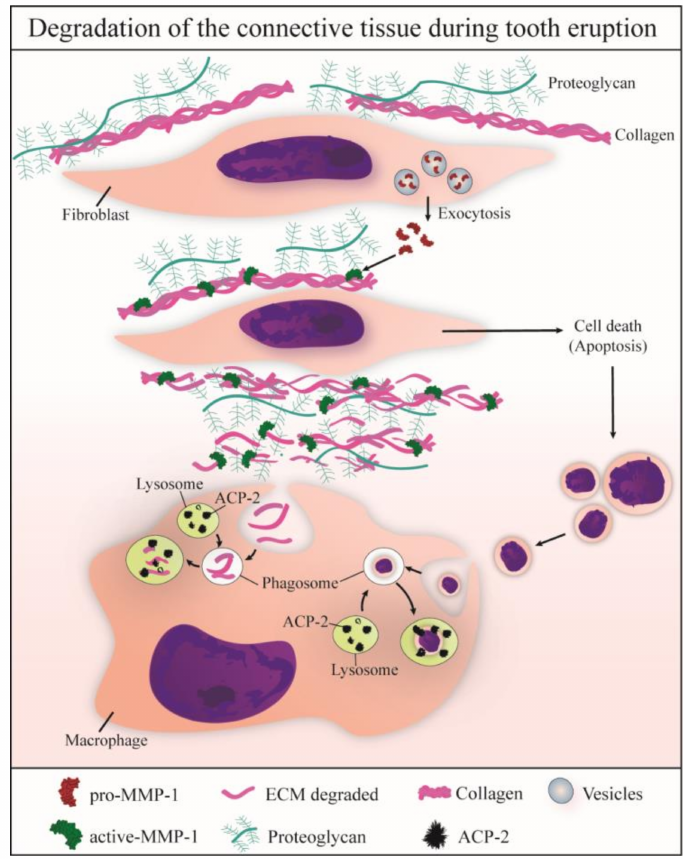
Figure 10. Schematic figure showing some mechanisms involved in the degradation of ECM of eruptive pathway during the normal tooth eruption. Fibroblasts produce and release pro-MMP-1, which is activated in the extracellular microenvironment and becomes active-MMP-1. This enzyme degrades collagen fibrils surrounding fibroblasts and other cells, which undergo apoptosis. Either collagen fragments or apoptotic bodies are engulfed by neighbouring macrophages. Phagosomes containing collagen and/or apoptotic bodies are fused with lysosomes containing lysosomal enzymes, such as ACP-2, which allows the intracellular digestion of these eruptive pathway